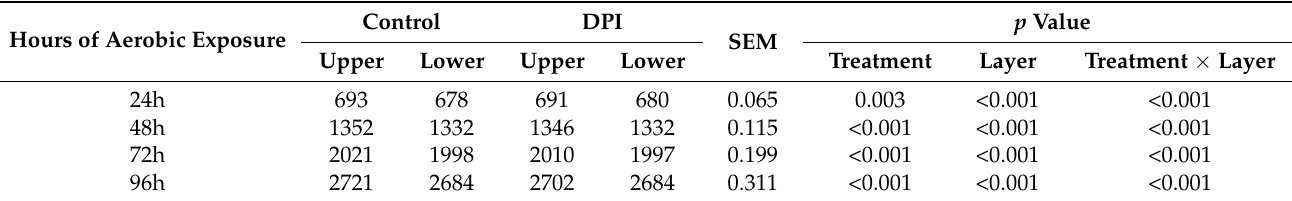
Table 4. Effects of inoculant application 1 on heat accumulation in different layers of bunker silage during feed-out at field